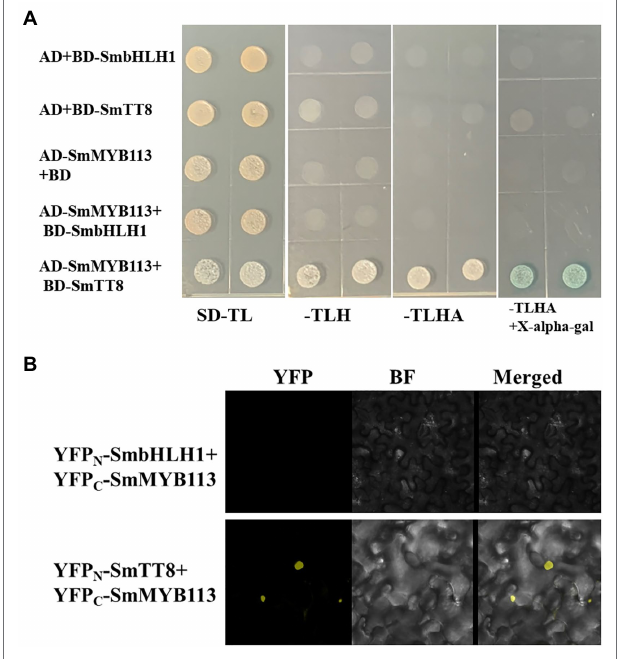
FIGURE 4 | SmbHLH1 could not specifically interact with SmMYB113 in both Y2H and bimolecular fluorescence complementation (BiFC) assays, while SmTT8 could. (A) The yeast cells of strain AH109 harboring the indicated plasmid combinations were grown in SD-TL ( − Trp/ − Leu), SD-TLH ( − Trp/ − Leu/-His), SD-TLHA ( − Trp/ − Leu/-His/ − Ade) mediums, and SD-TLHA ( − Trp/ − Leu/-His/ − Ade) with X-alpha-gal filter assay were indicated. (B) YFP fluorescent and bright-field images of Nicotiana benthamiana leaf cells infiltrated with a mixture of Agrobacterium suspensions harboring constructs encoding the indicated fusion proteins.